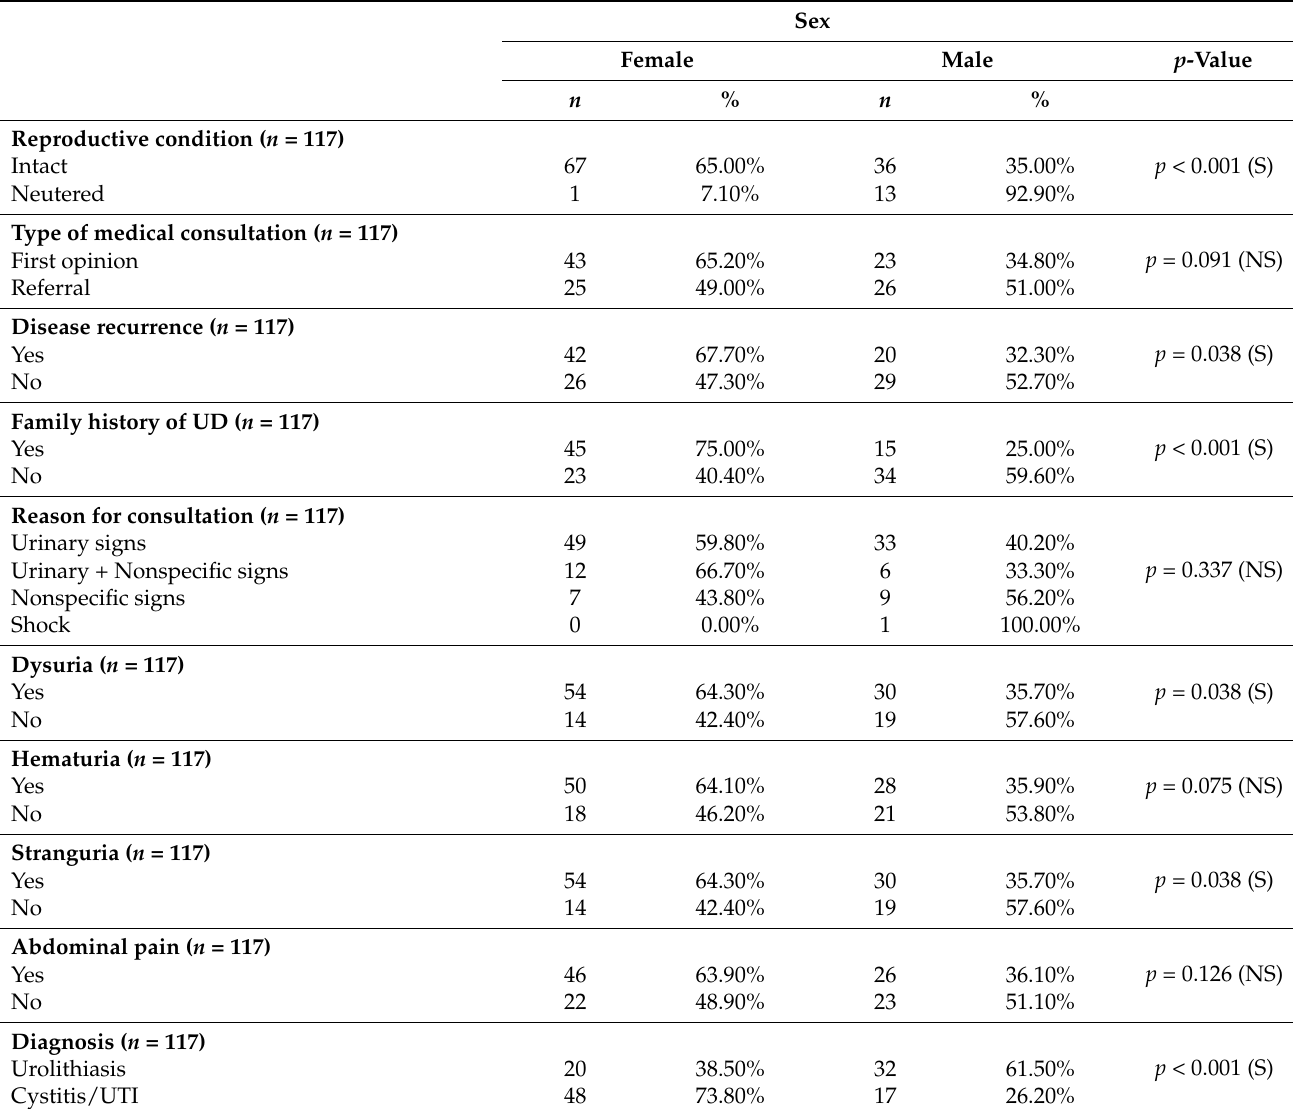
Table 1. Association between patient and diagnostic features with the guinea pigs’ sex (female versus male) in 117 clinical cases diagnosed with lower urinary tract